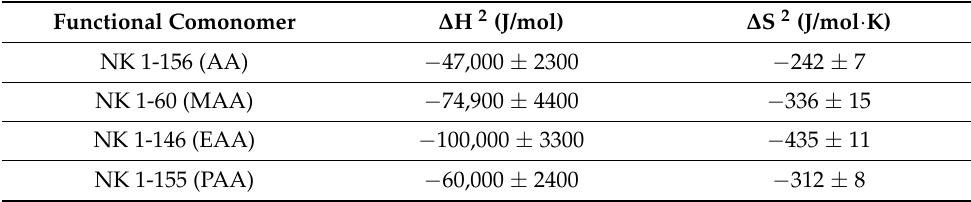
Table 5. Changes in Enthalpy 1 and Entropy 1 That Occur Due to Polymer